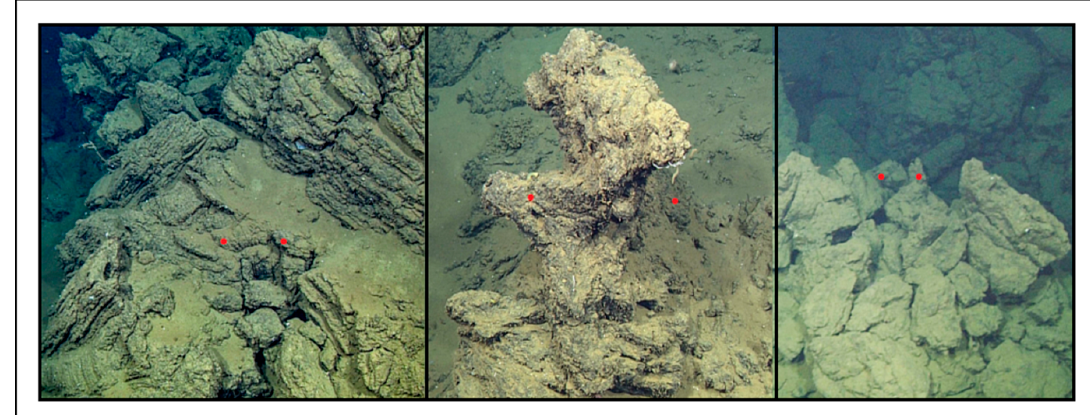
Figure 5. Examples of rhyolitic lava flows in ROV Doc Ricketts images. Laser spacing (red dots) is 70 cm. Rhyolitic flows can be blocky and angular with deep corrugation (left), form branches with jagged nodules (middle), or sometimes resembles blocky breccia (right).